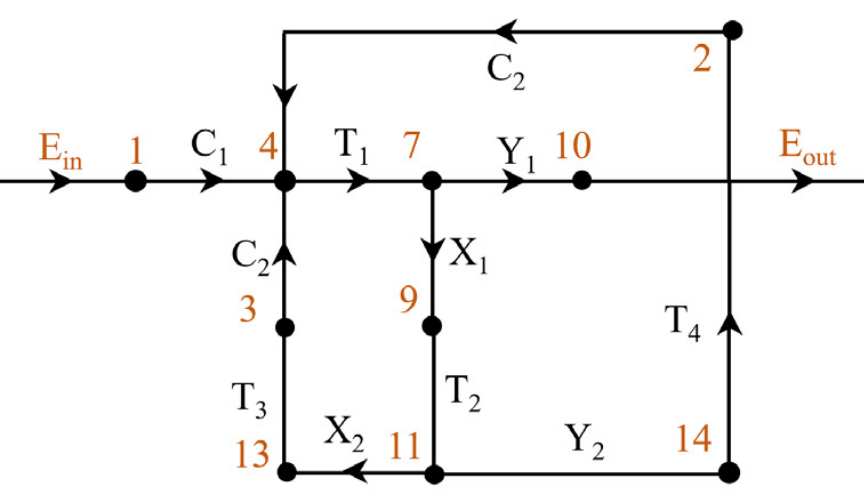
Figure 2. Signal-flow graph of the TCR-CC filter.